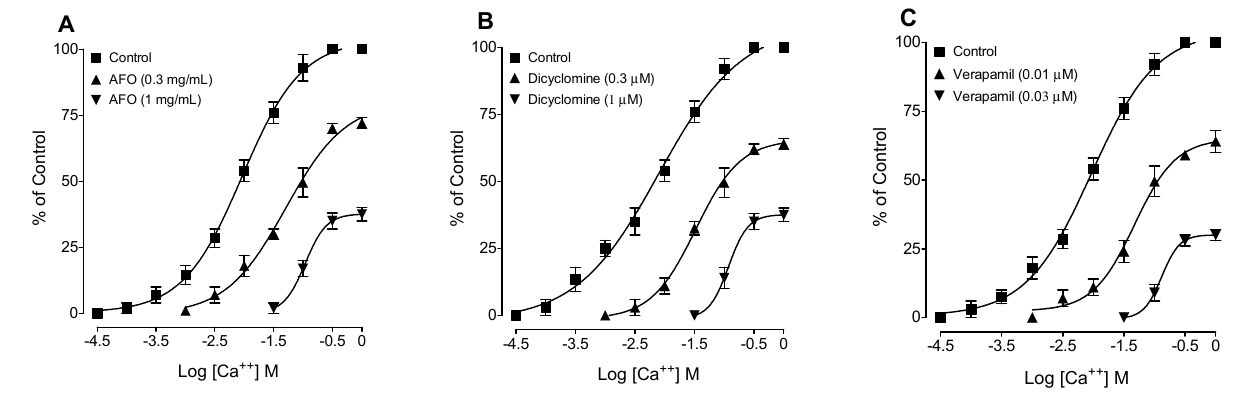
7 of 11 Figure 4. Concentration ‒ response curves of carbachol (CCh) in the absence and presence of the increasing concentrations of the ( A ) essential oil (AFO), ( B ) dicyclomine and ( C ) atropine in iso- lated guinea pig tracheal preparations. Symbols represent mean ± SEM; n = 5. The effect of AFO to inhibit Ca ++ channels was further authenticated when the tra-